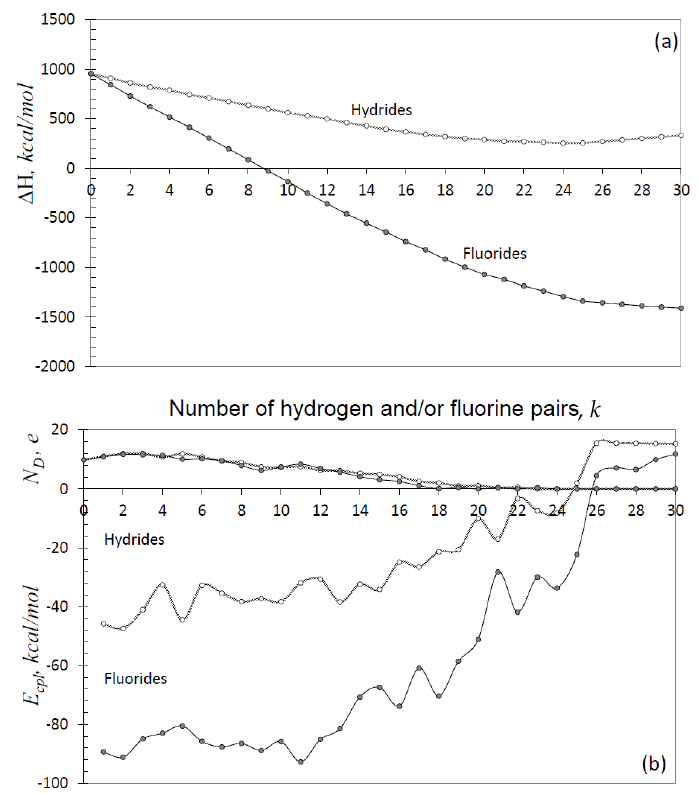
Figure 7. Evolution of the total energy ∆ H ( a ), molecular chemical susceptibility N D , and per-step coupling energy E cpl ( b ) at growing the number of atom pairs k for C 60 hydrides (dotted curves with empty circles) and C 60 fluorides (solid curves with filled